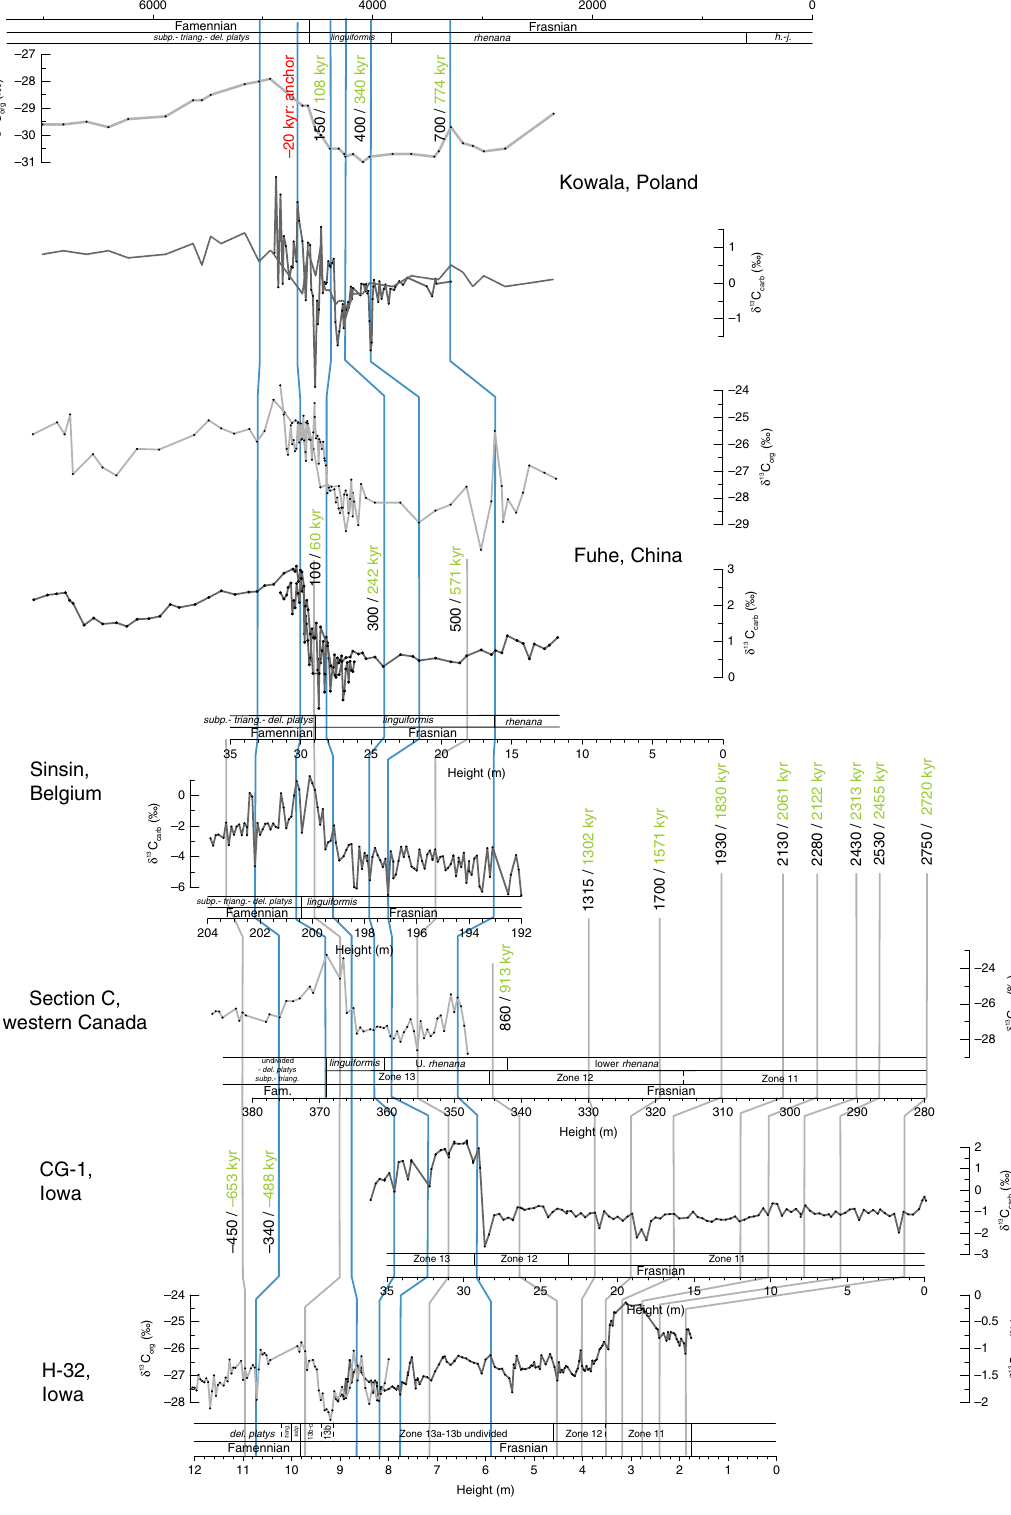
Fig. 6 Carbon isotope correlation. Tie-points between H-32, CG-1, Section C, Sinsin, Fuhe, and Kowala were obtained by visually correlating distinct features in carbon isotope geochemistry (blue ties). The gray ties were established by correlating distinct features in magnetic susceptibility (Fig. 5). We construct a common fl oating age model for all sections by assigning an age relative to the F – F boundary to each tie-point, according to the existing astrochronologic framework of Section C and Kowala 15, 17 . These ages are listed in black. The tie-point ages listed in green indicate the “ optimized ” tie- point ages, after 1000 Monte Carlo simulations ( “ Methods ” ). The latter tie-point ages are used for the depth-to-time conversion used in Figs. 2 and 3.